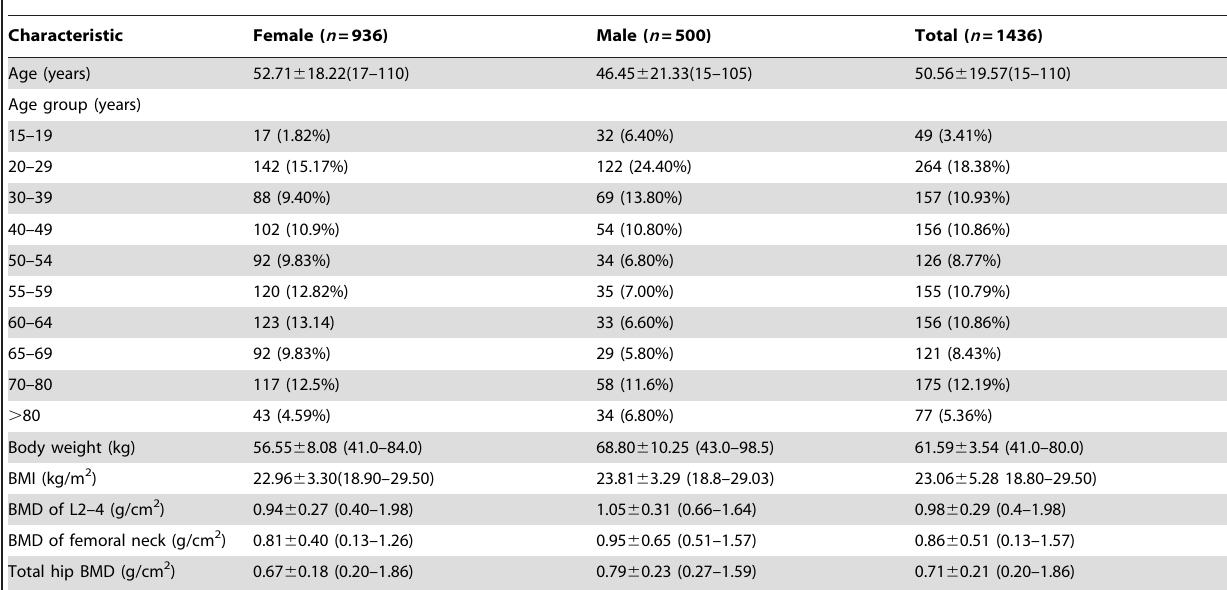
Table 1. Characteristics and age distribution of the study population.